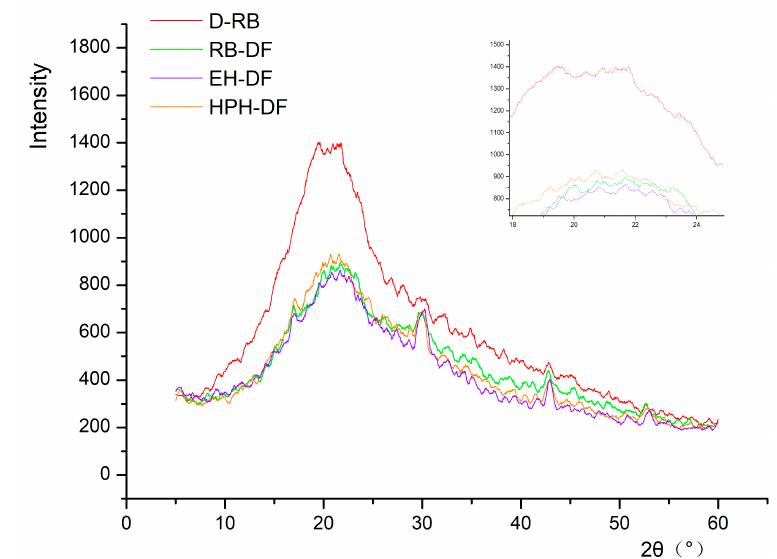
Figure 2. X-ray diffraction patterns of rice bran dietary fiber at different treatment stages. Inset shows main diffraction peaks about rice bran in four treatment stages. D-RB defatted rice bran, EH-DF cellulase enzymatic treatment rice bran dietary fiber, HPH-DF high-pressure treatment rice bran dietary fiber, RB-DF rice bran dietary fiber.